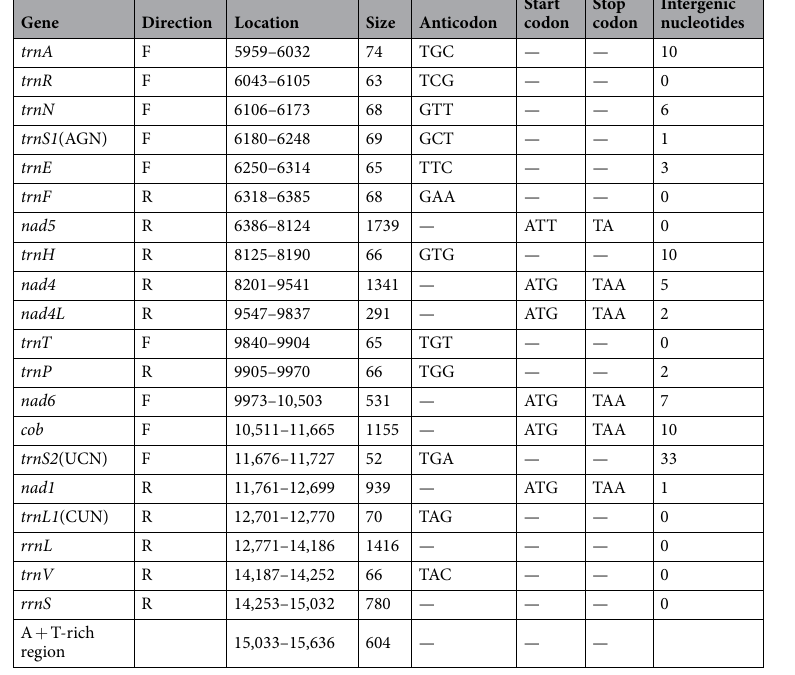
Table 3. Summary of the mt genomes of A . rubiginosa and R . menciana .